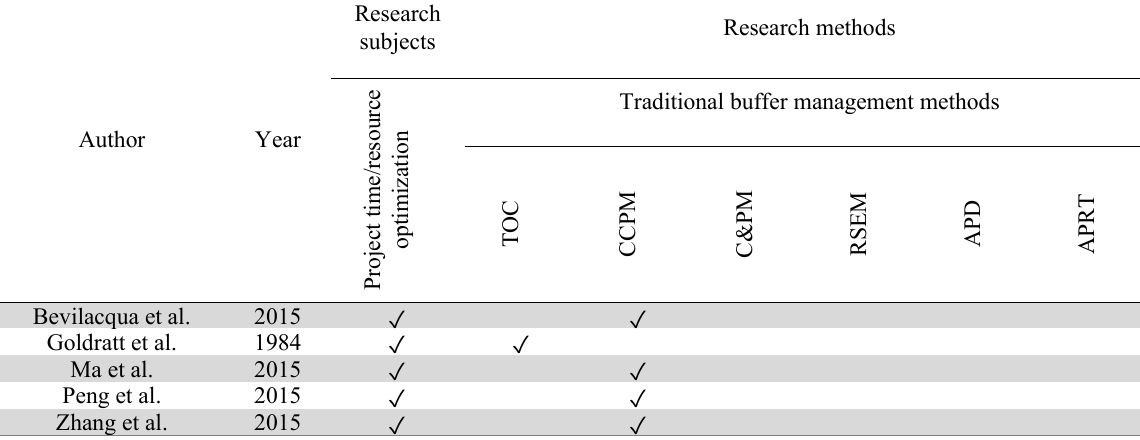
Project time/resource optimization: Traditional buffer management